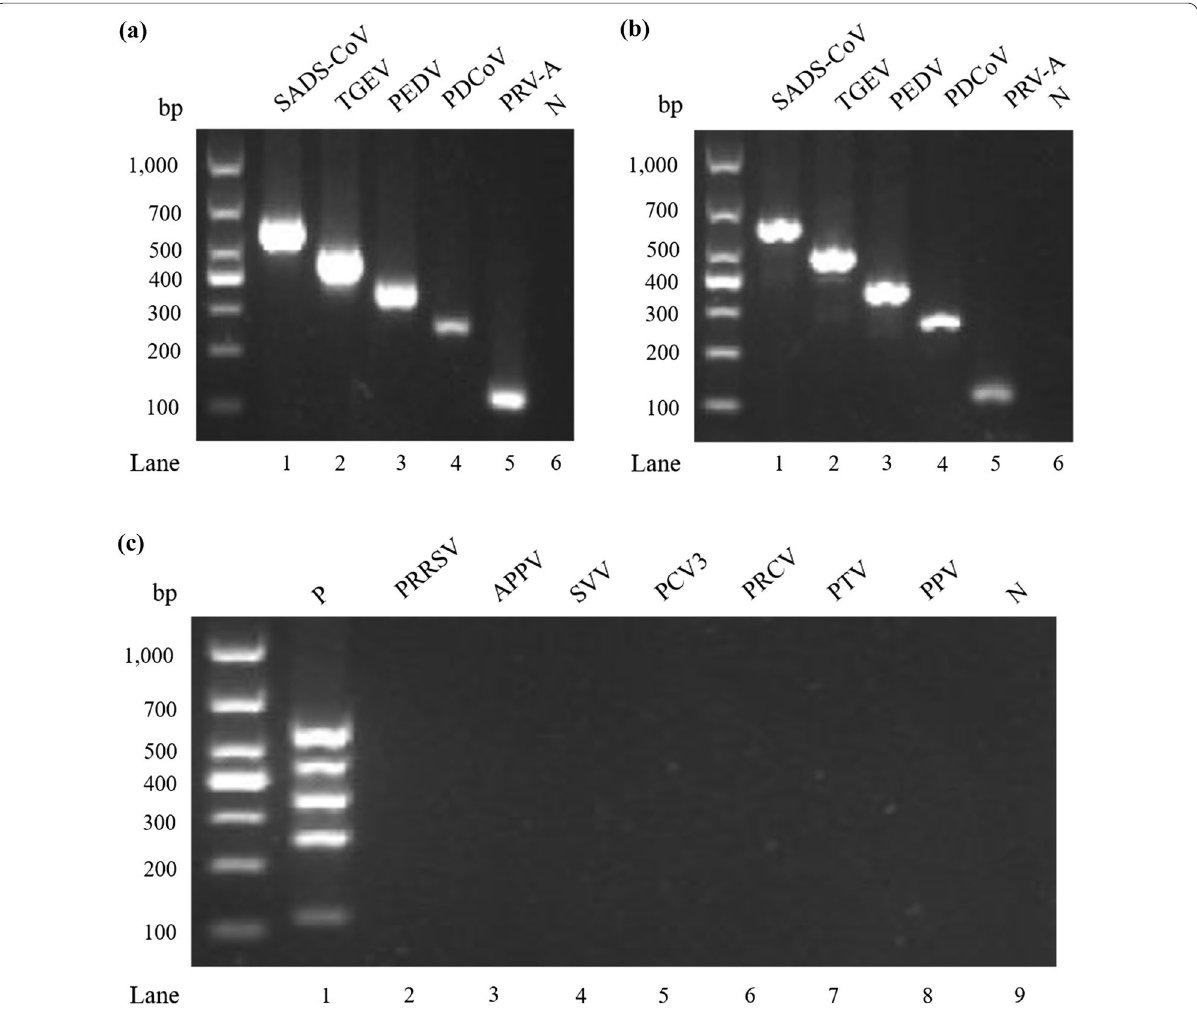
Fig. 4 Detection specificity of SADS-CoV, TGEV, PEDV, PDCoV, and PRV-A by the DPO system-based multiplex RT-PCR. a A single pair of the DPO primer was used to amplify the mixture of the five plasmid templates. (Lanes 1–6: SADS-CoV, TGEV, PEDV, PDCoV, PRV-A, and negative control). b The mixture of the five DPO primers was used with each of the five plasmid templates individually, for amplification (Lanes 1–6: SADS-CoV, TGEV, PEDV, PDCoV, PRV-A, and negative control). c Detection of the other diarrhea viruses (Lanes 1–9: positive control (P), PRRSV, APPV, SVV, PCV3, PRCV, PTV, PPV, and negative